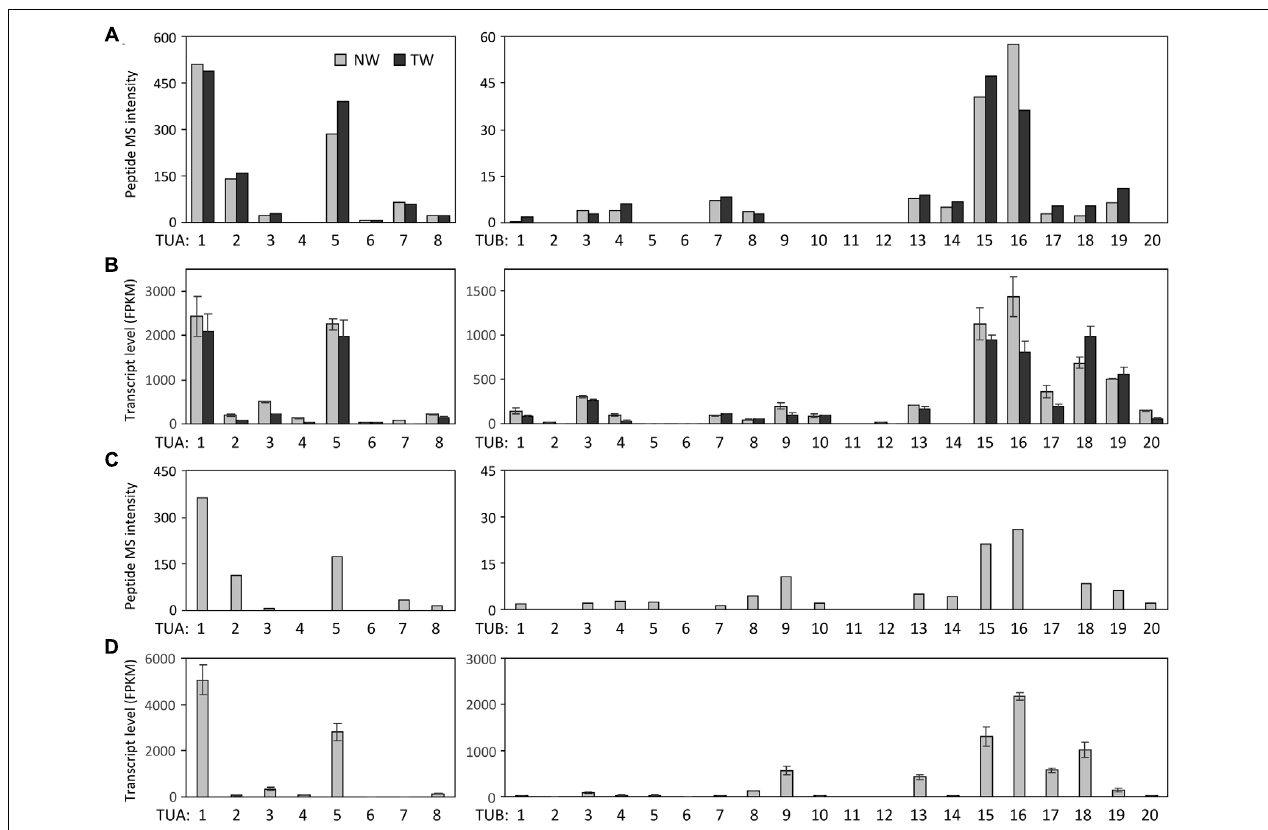
FIGURE 2 | Tubulin isotype and transcript abundance in xylem. (A) Label-free MS quantification of TUA (left panel) and TUB (right panel) reporter peptides in normal wood (NW) and tension wood (TW) of P. deltoides . (B) TUA and TUB transcript abundance based on RNA-Seq analysis of P. deltoides NW and TW samples ( n = 2). (C) Label-free MS quantification of TUA and TUB based on a previously published P. tremula × alba NW xylem dataset (Swamy et al., 2015). (D) TUA and TUB transcript abundance based on RNA-Seq analysis of P. tremula × alba NW samples ( n =